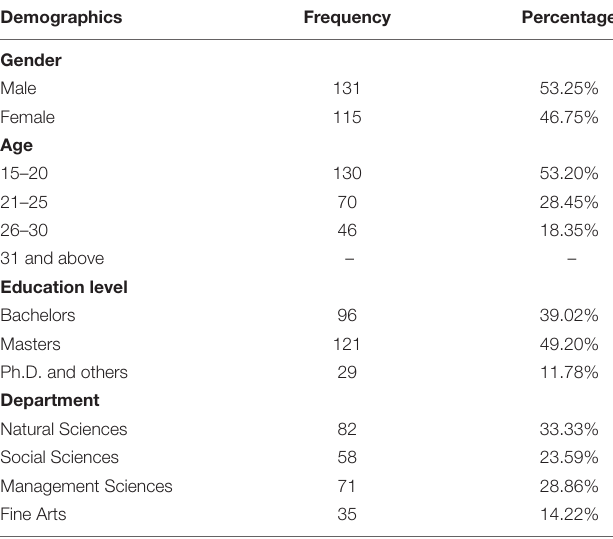
Frontiers in Psychology |